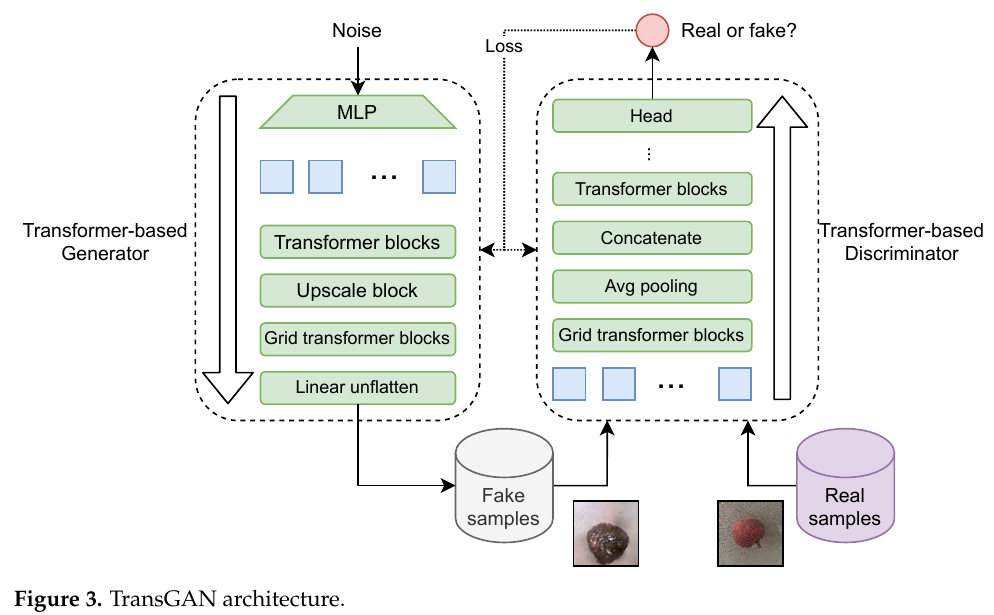
Figure 3. TransGAN